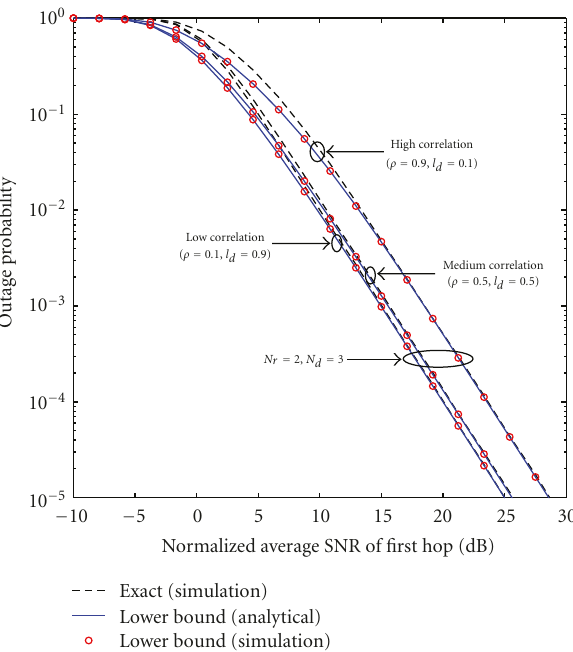
Figure 6: Impact of antenna spacing/angular spread at the destina- tion on the average BER of BPSK. γ θ d = π/ 6.